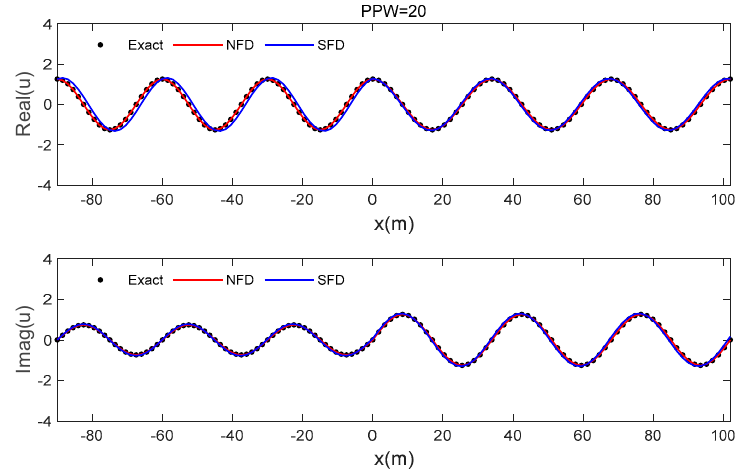
Figure 4. The real and imaginary parts of solutions in the plane-wave reflection case with PPW = 10.